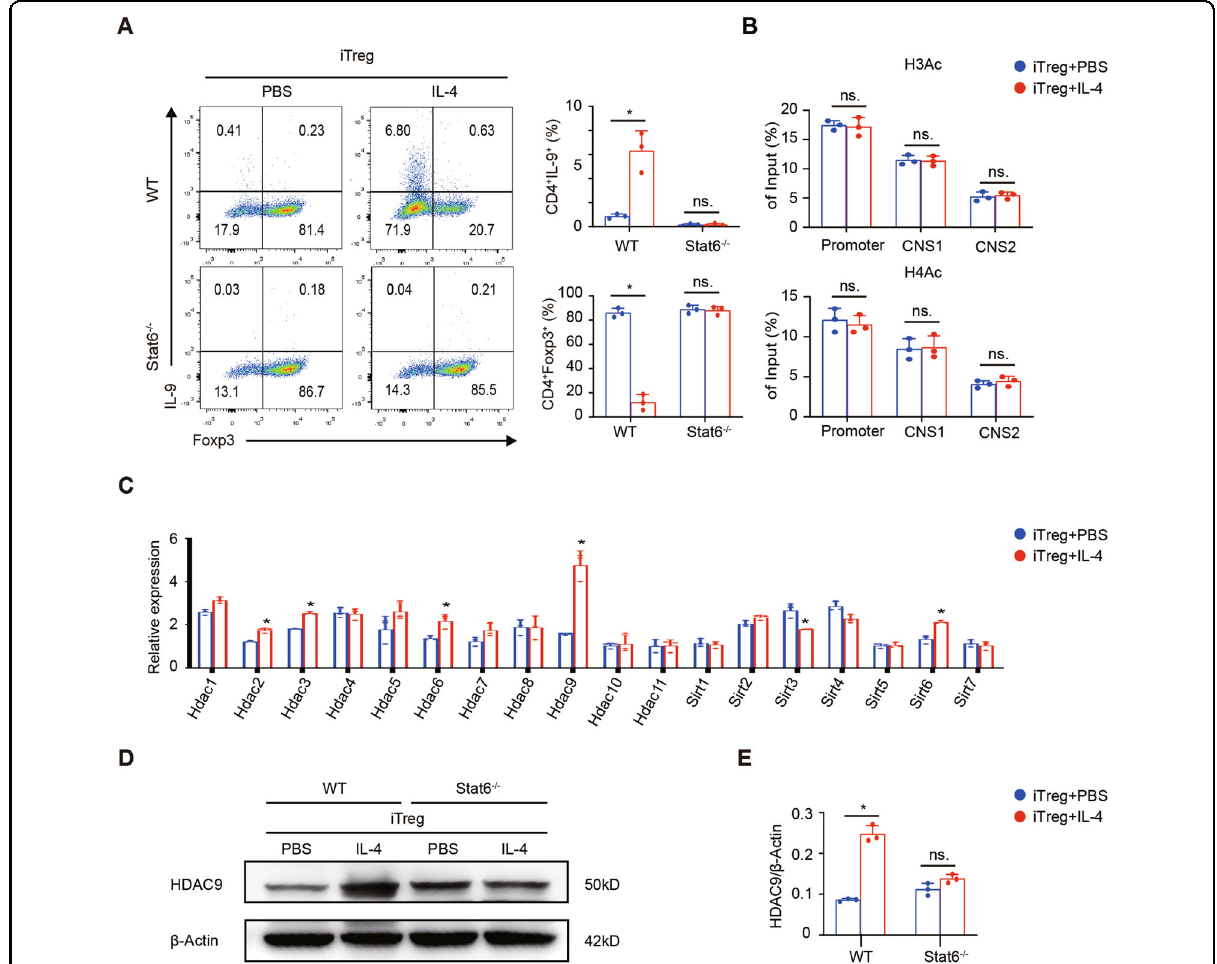
Fig. 4 HDAC9 is involved in IL-4-STAT6-mediated epigenetic changes. A Naive CD4 + T cells were FACS sorted from WT B6 and stat6 -/- mice and cultured under iTreg-polarizing conditions with or without IL-4. The cells were harvested on day 2 ( B , C ) or day 3 ( A , D ). A An FCM assay was used to measure the percentages of Foxp3 + cells among CD4 + T cells in different group. B ChIP-qPCR assays for H3Ac and H4Ac modi fi cations in the Foxp3 promoter, CNS1, and CNS2 regions with T cells from stat6 -/- mice. C The graphs display Hdac1-11 and Sirt1-7 mRNA expression in the cultured cells relative to that in naive CD4 + T cells. D An immunoblot assay evaluating HDAC9 expression was performed. E The graphs show quantitation of HDAC9 expression in three independent western blot experiments. Data are the mean ± SD and representative of three independent experiments. * p <